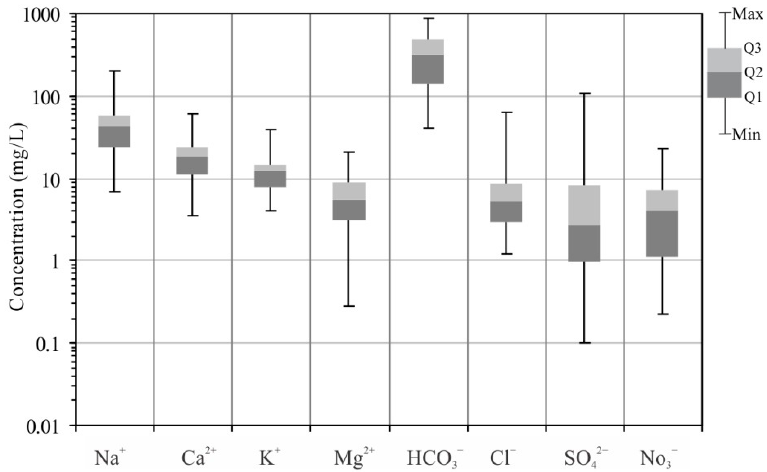
Figure 2. Box and whisker showing variability of chemical composition of the groundwater. Q1, Q2 and Q3 represent the first, the second and the third quartile, respectively.